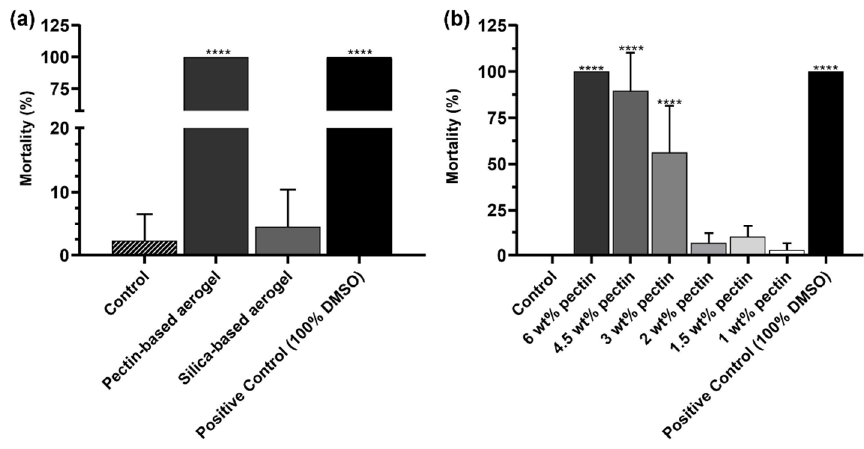
Figure 10. Mortality (%) of Artemia salina incubated for 24 h with aerogel structures ( a ) and with pectin solutions at different concentrations ( b ). Artemia salt medium (Control) was used as negative control of mortality (%), whereas 100% of DMSO was used as positive control. The results represent the mean value ± SD, n > 4. Statistical significance represents **** p < 0.0001 compared with the group incubated only with artemia salt medium.